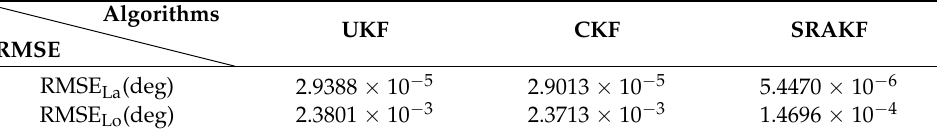
Figure 18. Longitude errors for the robustness lake trial. Table 5. RMSE for different